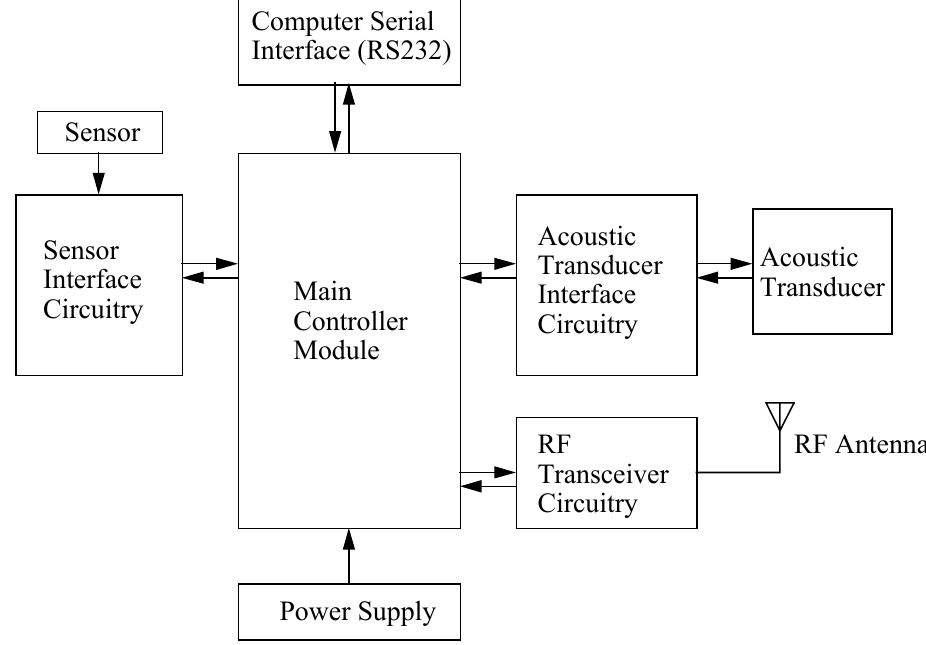
Figure 2. Block diagram showing the components of an aqueous sensor node. The host node connects directly to a computer, and contains a RF transceiver for communication with the network uplink node. The uplink node has both a RF transceiver and acoustic transducers, while the rest of the nodes have only acoustic